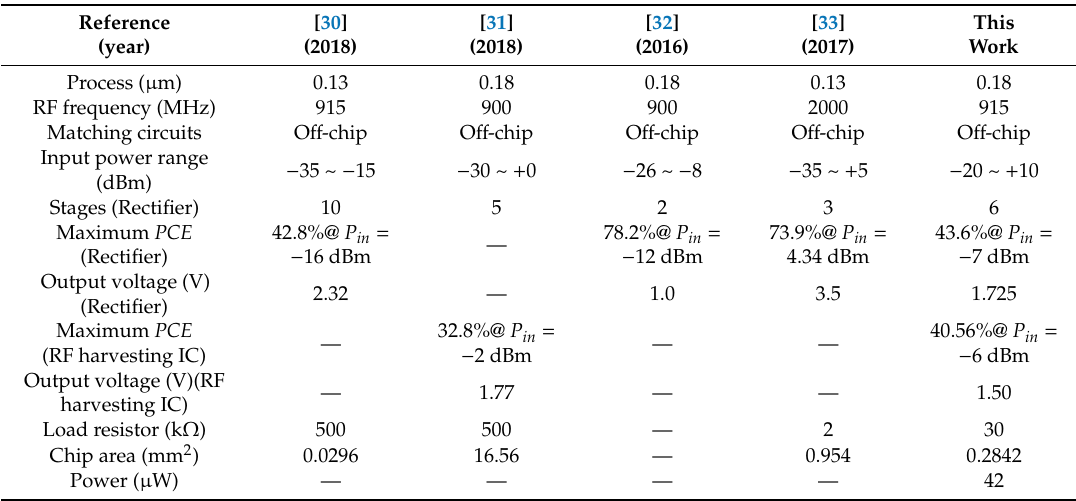
Table 5. Summary of performance and its comparison with those of other RF-DC rectifiers and RF-energy-harvesting